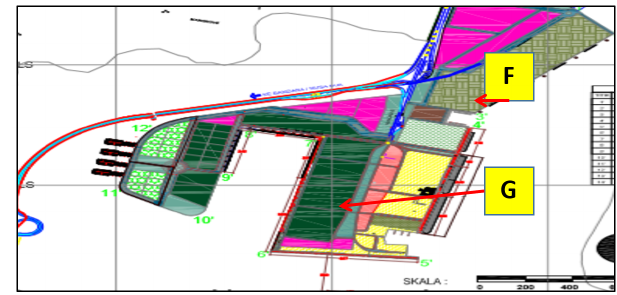
Fig. 6. Planned Allocation of Wharf Development Fig. 7. Allocation Plan for Wharf Development in Long